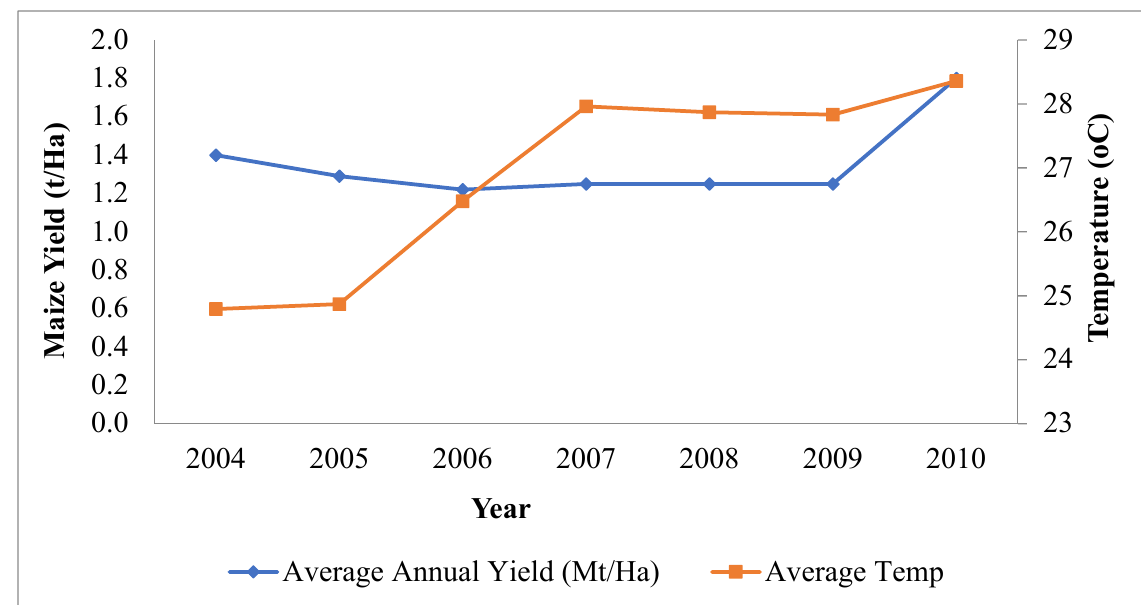
Figure 8. Relationship between total average annual temperature (°C) and annual maize yield (t/Ha).